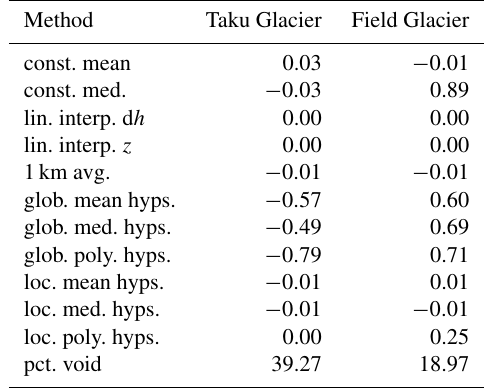
Table 2. Difference to true volume change for two of the glaciers with the largest individual differences (Taku Glacier: 0.11ma − 1